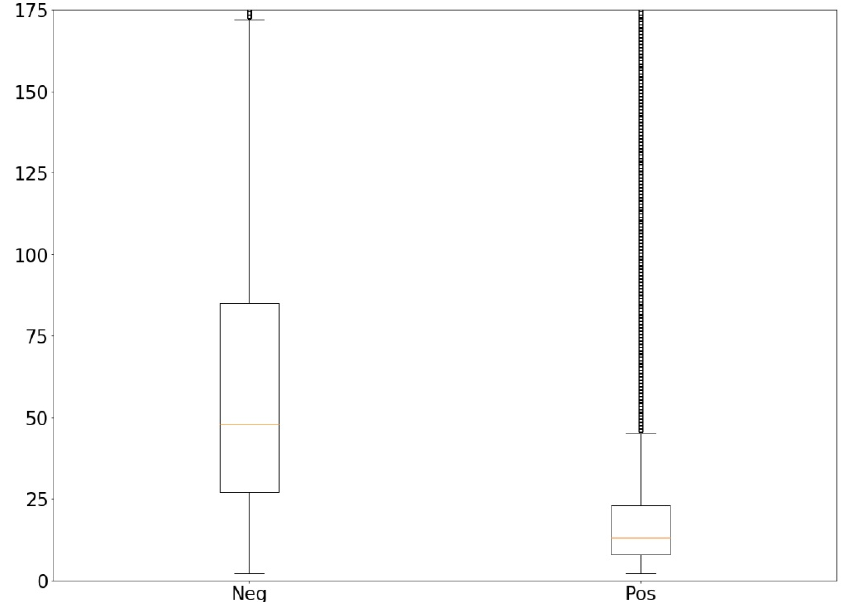
Figure 7. Boxplots of the number of tokens for negative–positive sentimental statements.